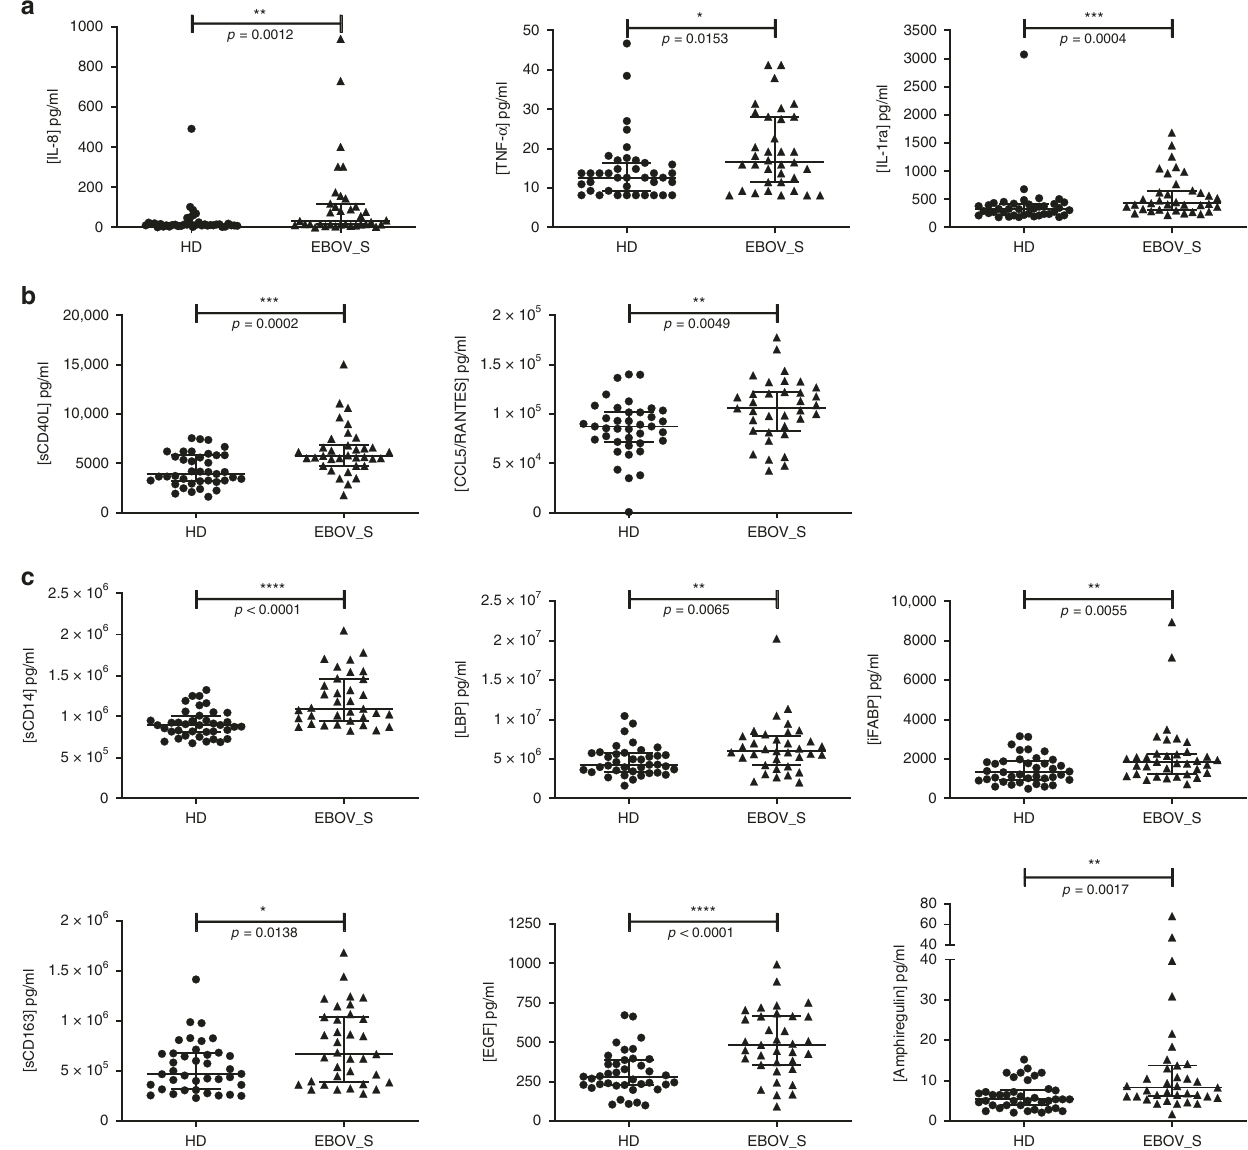
Fig. 1 Quanti fi cation of serum-soluble mediators differentially expressed in HDs and EBOV_S. Measurement of serum-soluble mediators (pg/ml) from n = 39 HDs and n = 35 EBOV_S with the Bio-Plex 200 System TM (Bio-Rad). Pro-in fl ammatory and anti-in fl ammatory cytokines ( a ). Markers of T cell function ( b ). Markers of gastric tissue integrity ( c ). The differences between HDs and EBOV_S were evaluated in nonparametric Mann – Whitney U tests. Median values± IQR are shown. Source data are provided as a Source Data fi